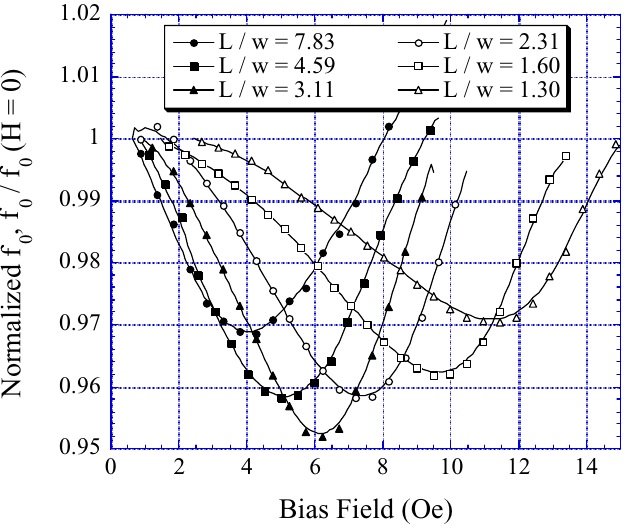
Figure 18. The applied bias field required for the sensor to exhibit maximum ∆ E effect increases with decreasing sensor length to width